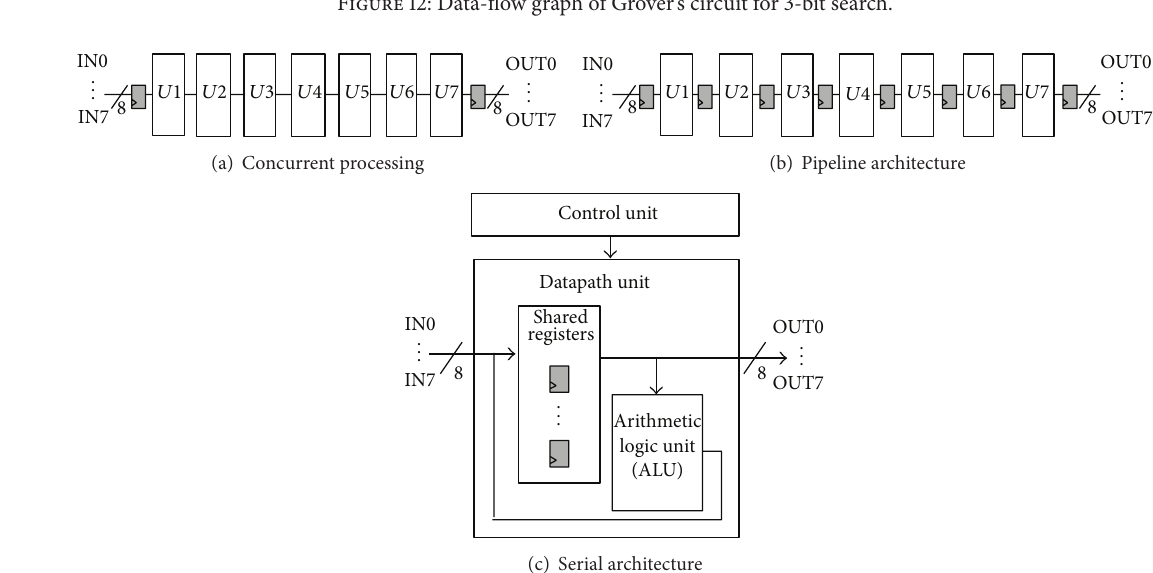
Figure 12: Data-flow graph of Grover’s circuit for 3-bit search.